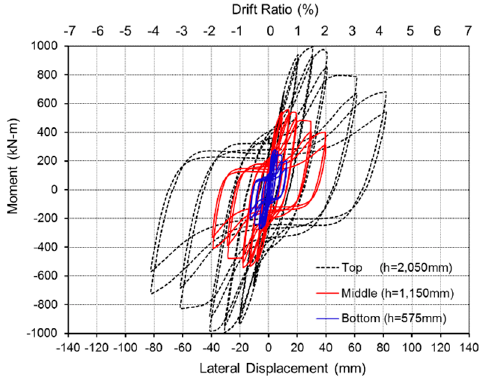
Figure 30. Load–displacement hysteresis curve of SP-W. Table 3. Test results.